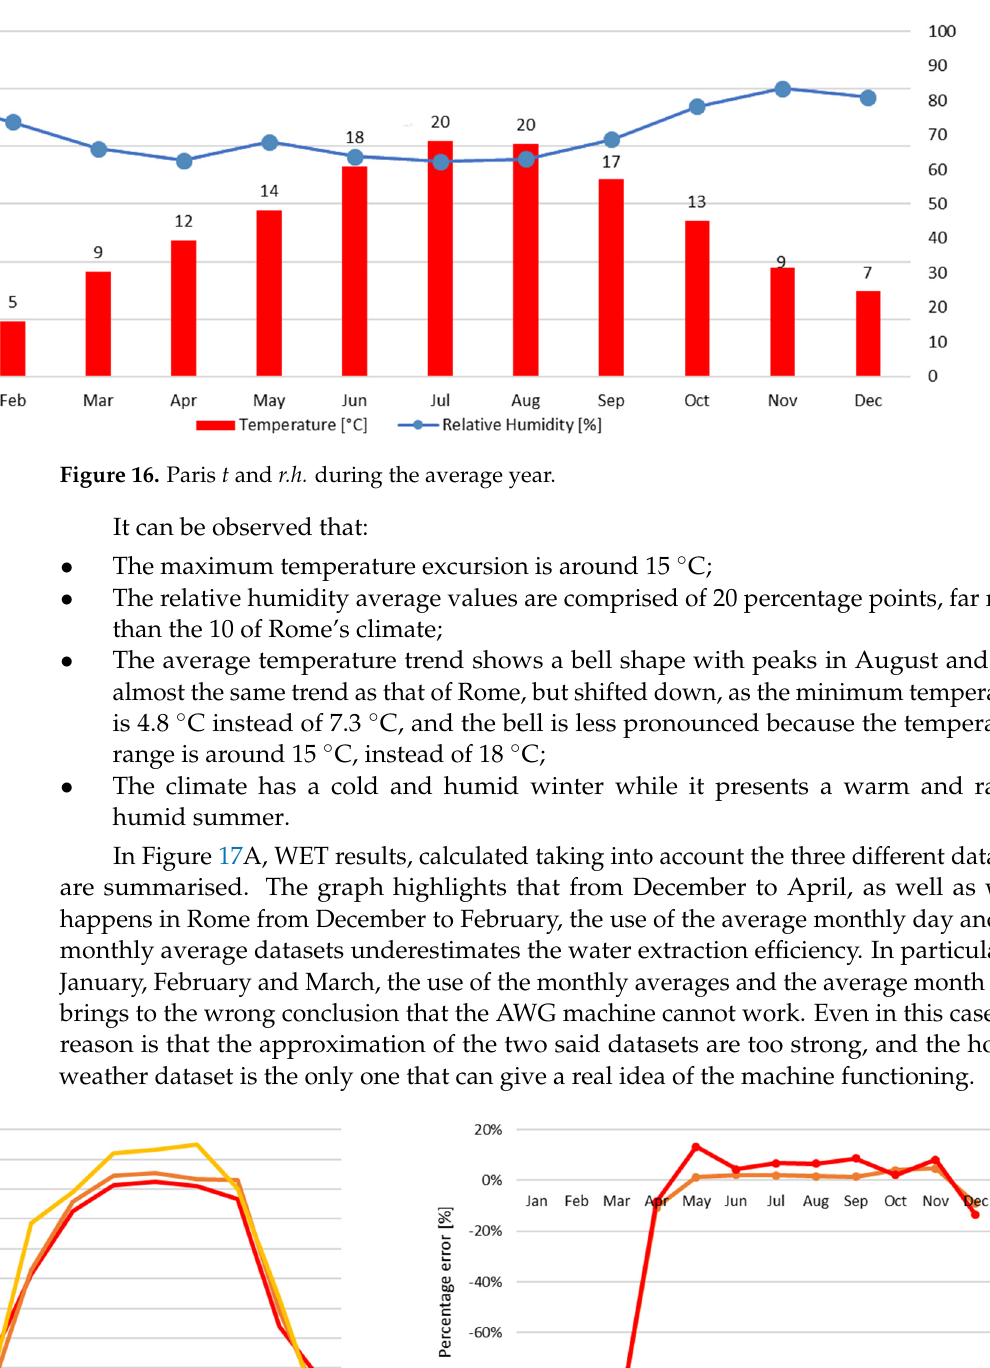
monthly averages, and to 2.9% using the average month days. For the MHI, the error trend